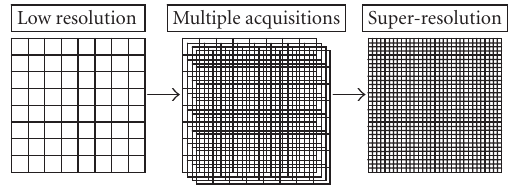
Figure 1: Super-resolution algorithms combine multiple low-reso- lution image acquisitions into a high-resolution